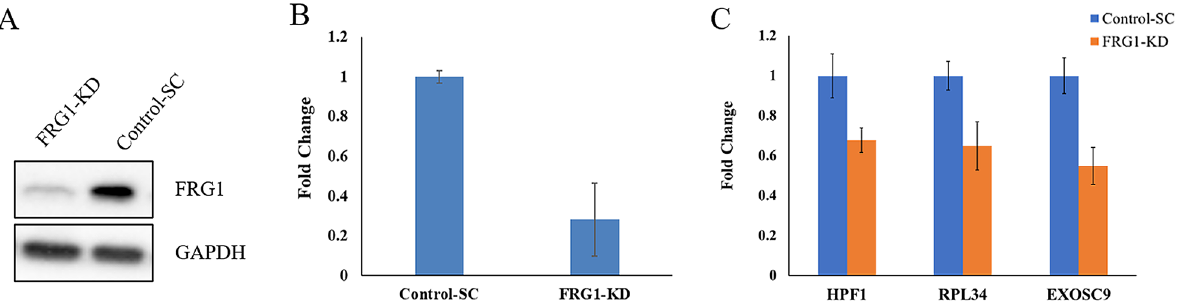
Figure 7. Effect of FRG1 expression on other genes. ( A ) Western blot showing FRG1 expression in HEK293T cells with FRG1 knock down (FRG1-KD) and respective control (Control-SC). ( B ) The bar graph shows the levels of FRG1 mRNA in HEK293T cells with FRG1 knock down (FRG1-KD) and respective control (Control-SC) (n = 3). ( C ) The bar graph shows the change in mRNA expression of HPF1, RPL34, and EXOSC9 in HEK293T cells with FRG1 knockdown (FRG1-KD) compared to the control (Control-SC) (n = 3). Y-axis shows fold change in expression using GAPDH as an internal control.